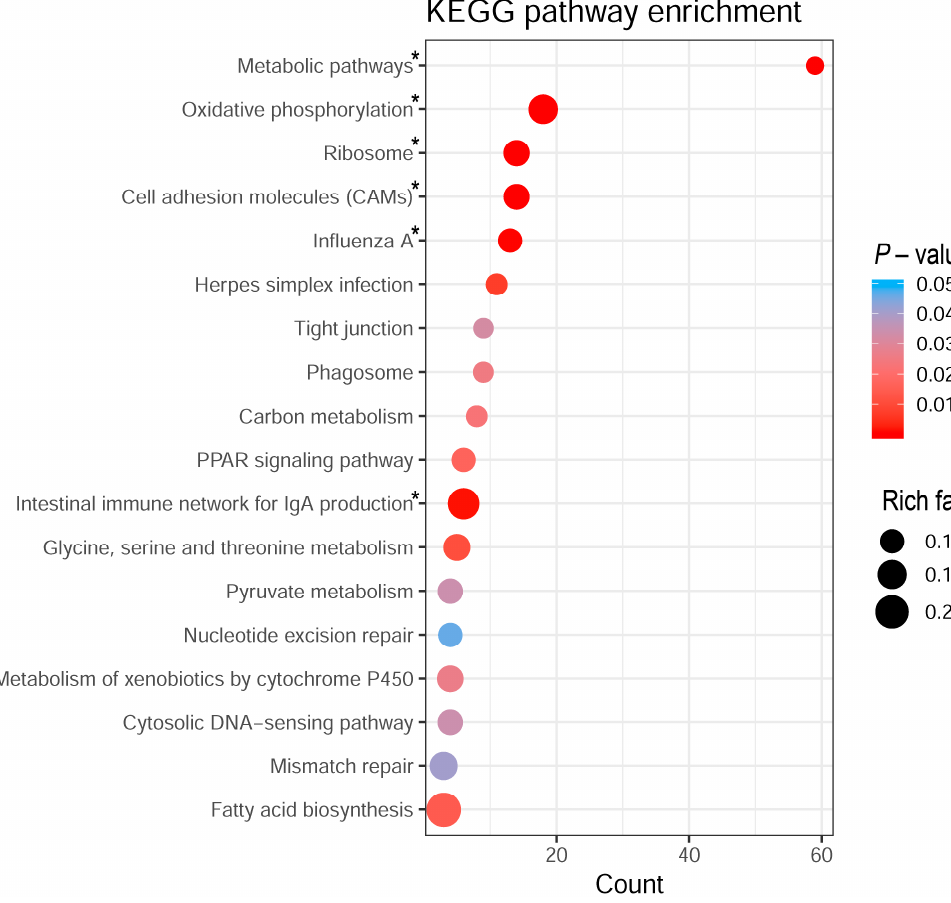
Figure 3. Kyoto Encyclopedia of Genes and Genomes (KEGG) pathways deduced from the 640 differentially expressed genes (DEGs) between quail assigned to high and low PU groups. Significantly enriched pathways are shown ( p -value ≤ 0.05). Pathways indicated by an asterisk remain after multiple testing correction (Benjamini–Hochberg adjusted p -value ≤ 0.05). Count—number of enriched DEGs; rich factor—ratio of DEG to the total number of genes annotated in the